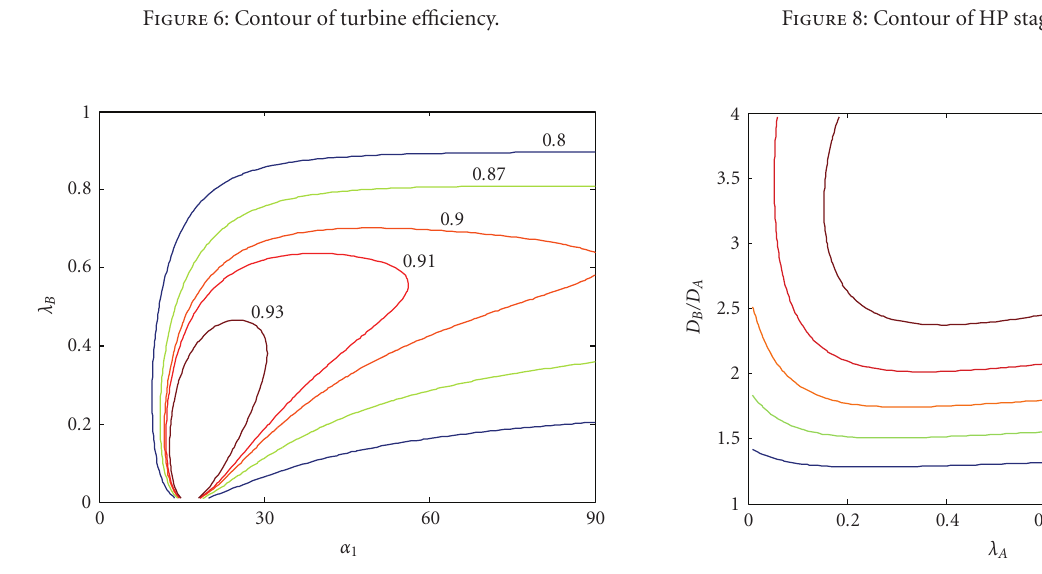
Figure 7: Contour of HP stage e ffi ciency.